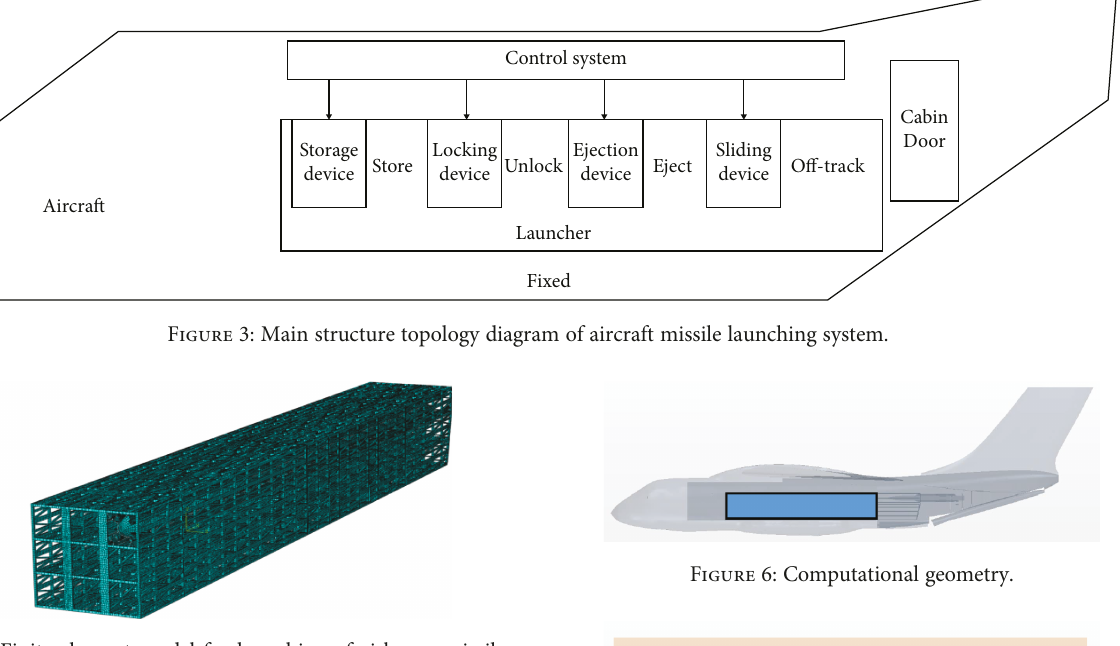
Figure 4: Finite element model for launching of airborne missile weapon system.